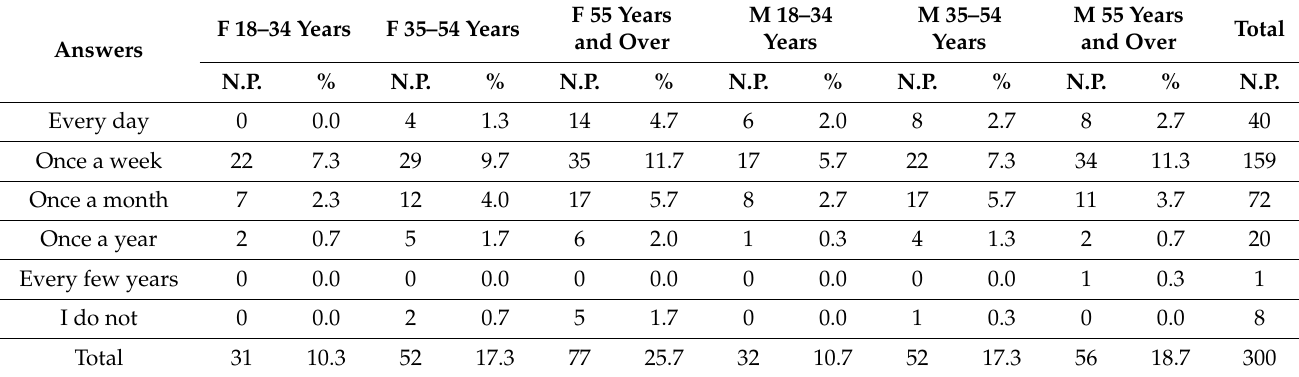
Table 3. Respondents’ answers (by sex and age) to the question: how often do you visit a forest or a park in the city of Sosnowiec? (Source: the